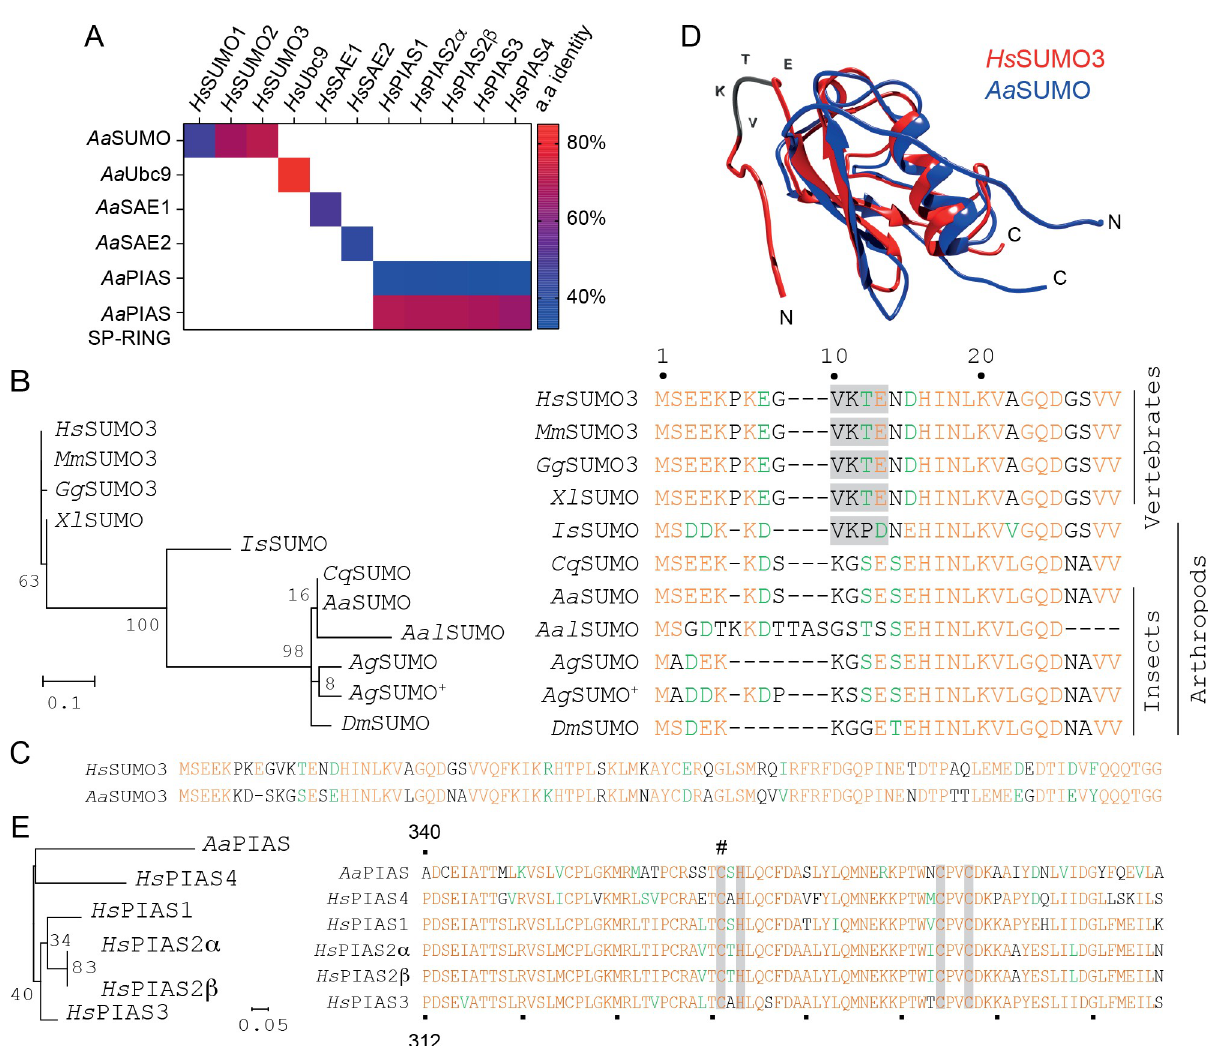
Fig 1. The Aedes aegypti SUMOylation pathway is highly conserved. (A) Colour-coded pairwise identity matrix showing the percentage amino acid (a.a) identity between orthologue proteins of the Aedes aegypti and Homo sapiens SUMOylation pathways. Each coloured cell represents the percentage identity score between two sequences. Colour key showing the correspondence between percentage identity and the colours displayed shown. (B) Phylogenetic tree and N-terminal amino acid alignment of SUMO proteins from a selection of model organisms (SUMO Uniprot accession number). Hs , Homo sapiens (P55854); Mm , Mus musculus (Q9Z172); Gg , Gallus gallus (Q5ZHQ1); Xl , Xenopus laevis (Q6DK72); Is , Ixodes scapularis (B7PKS5); Cq , Culex quinquefasciatus (B0WVZ6); Aa , Aedes aegypti (Q16EQ3); Aal , Aedes albopictus (A0A182H3N0); Ag , Anopheles gambiae (Q7PNJ2 and Q7PY16 + ); Dm , Drosophila melanogaster (O97102). Branch lengths are proportional to sequence divergence with bootstrap values shown. Conserved residues are shown in orange; residues with similarity in green. SUMO consensus motifs (SCM; C -Lys(K)-X-Asp(D)/Glu(E), where C represents a branched hydrophobic amino acid and X represents any amino acid) are higlighted in grey. (C) Amino acid alignment of full length Aa SUMO plotted against Hs SUMO3. (D) Predicted structure of Aa SUMO (blue) plotted against the resolved structure of Hs SUMO3 (red; PDB ID: 2MP2; [85]). Position and sequence of SCM in Hs SUMO3 highlighted (VKTE; grey). (E) Phylogenetic tree and amino acid alignment of the catalytic SP-RING domain of orthologue PIAS proteins from Ae . aegypti and H . sapiens . Uniprot accession numbers; Aa PIAS (Q1DH55), Hs PIAS1 (O75925), Hs PIAS2 α (O75928- 2), Hs PIAS2 β (O75928-1), Hs PIAS3 (Q9Y6X2), and Hs PIAS4 (Q8N2W9). Branch lengths proportional to sequence divergence with bootstrap values shown. Residues of Aa PIAS 340–418, Hs PIAS4 311–388, Hs PIAS3 312–390, Hs PIAS2 α 331–409, Hs PIAS2 β 331–409, and Hs PIAS1 320–398 shown. Zn 2+ binding residues highlighted by grey bars; cysteine (C371) marked with